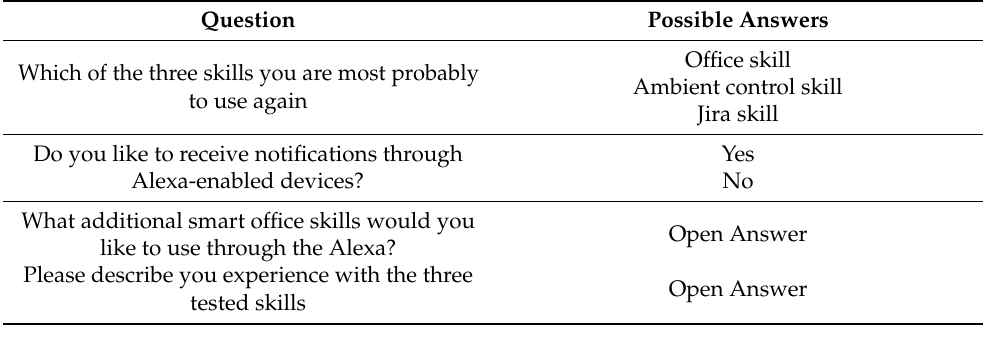
Table 4. Feedback survey questions (adapted after [41,54]).